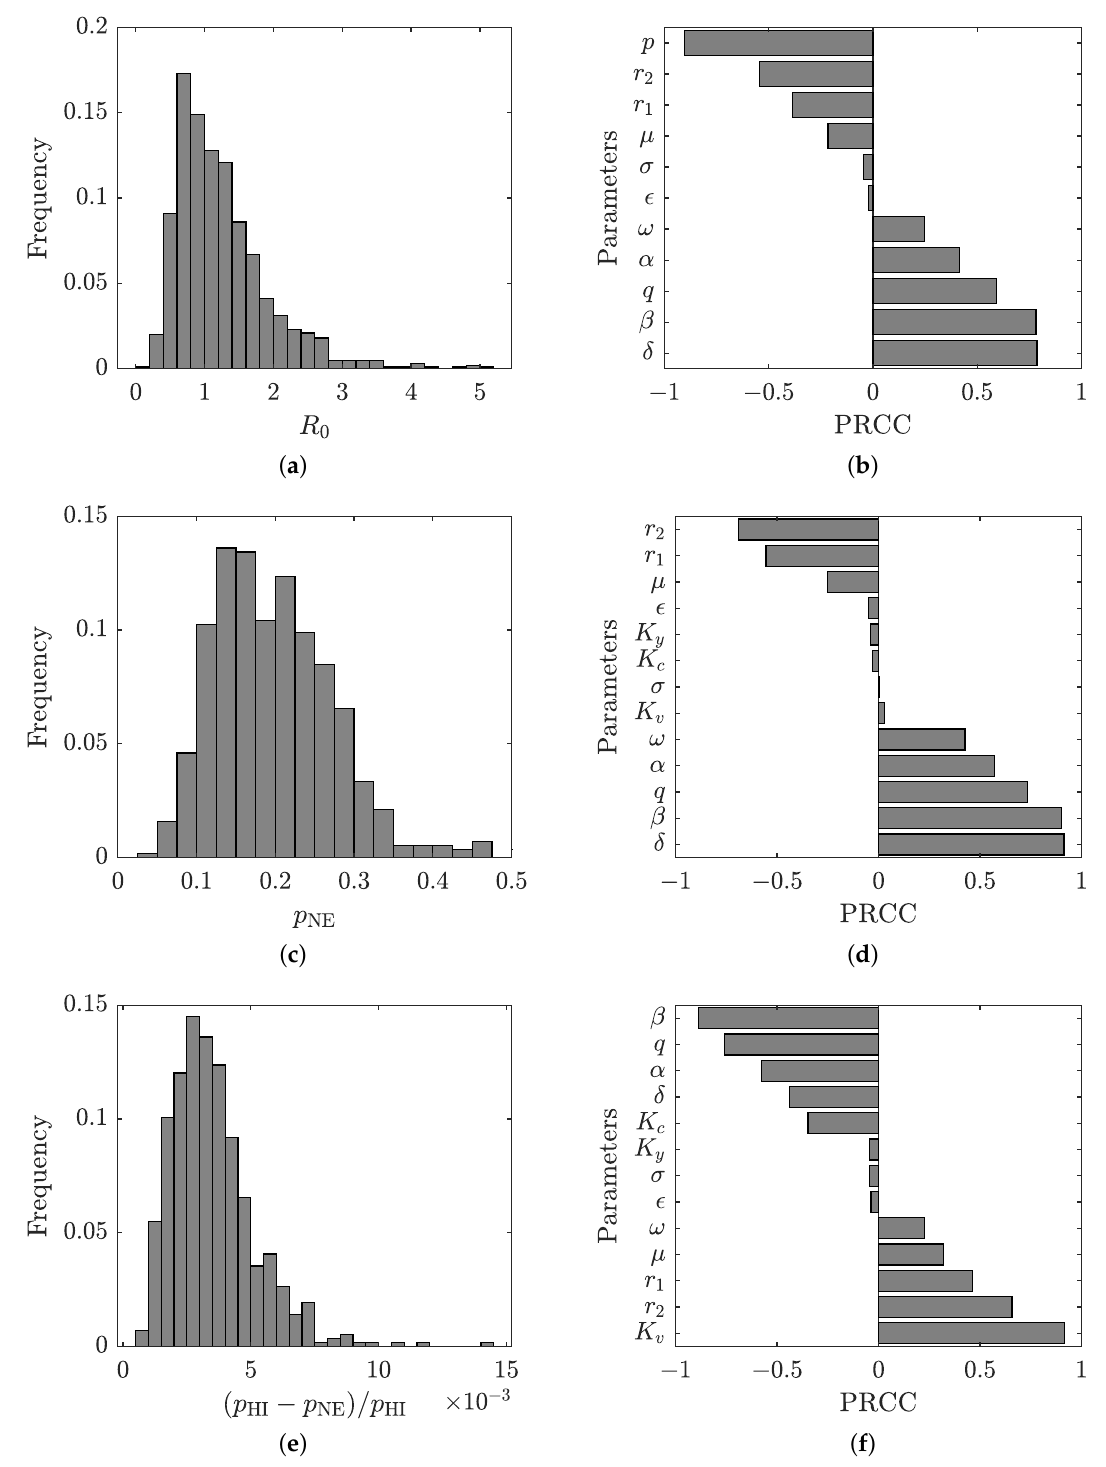
Figure 4. Results of the uncertainty (left-hand side panels) and sensitivity (right-hand side panels) analysis. Three response functions were considered: (1) the effective reproduction number R 0 (panels ( a , b )); (2) the optimal vaccination rate p NE when R 0 > 1 (panels ( c , d )); and (3) the relative difference between the herd immunity vaccination rate and the optimal vaccination rate | p HI − p NE | / p HI when R 0 > 1 (panels ( e , f )). The parameter ranges are as in Table